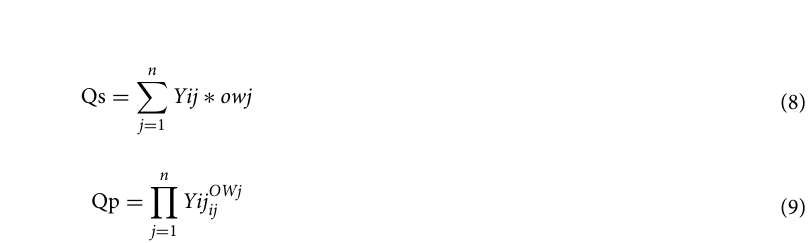
Table 7. Weighted normalized values in WASPAS